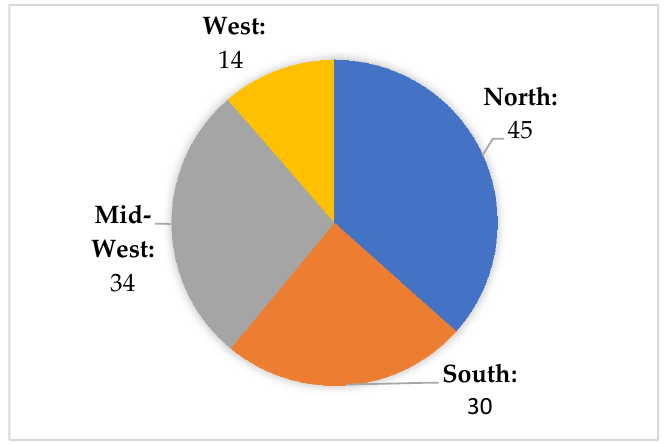
Figure 2. Location of Colleges in the Annapolis Group by Census Defined Region of the U.S. by Count.